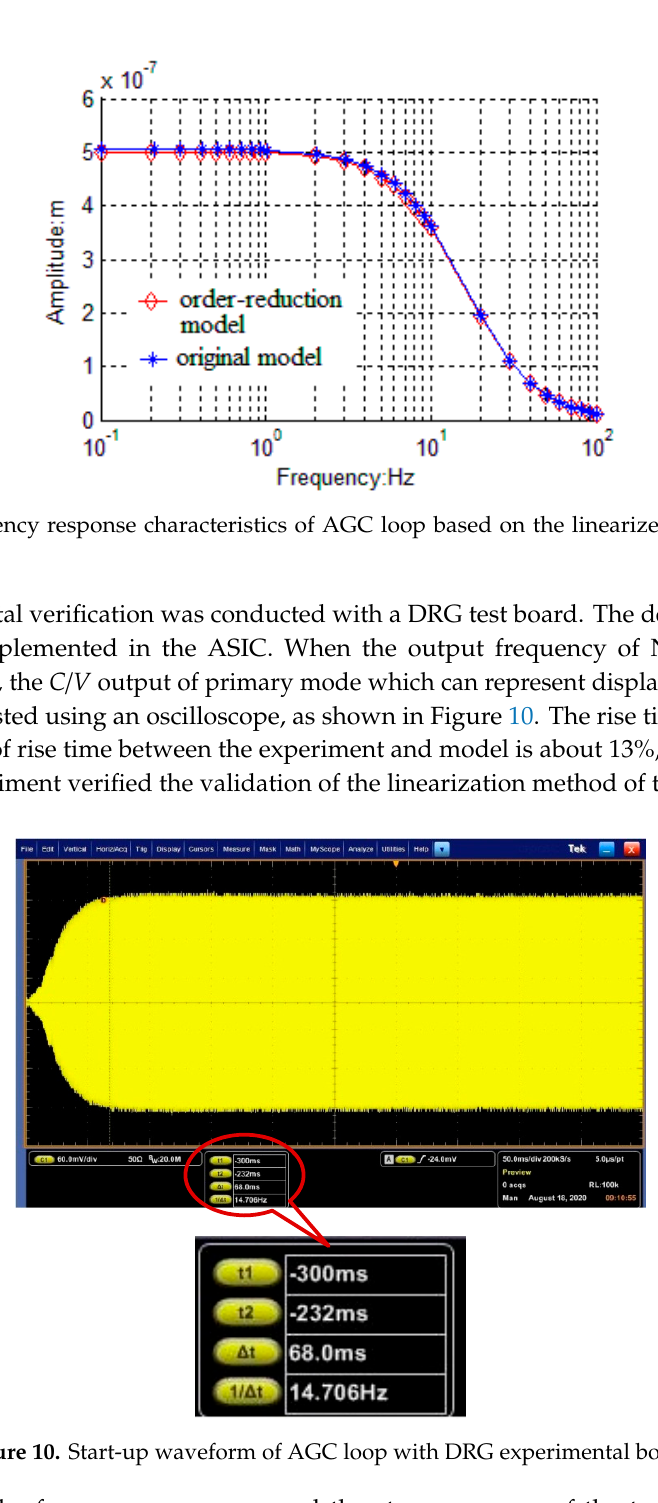
Figure 8. ( a ) Step response of AGC original model and ( b ) step response of the AGC linearized model.